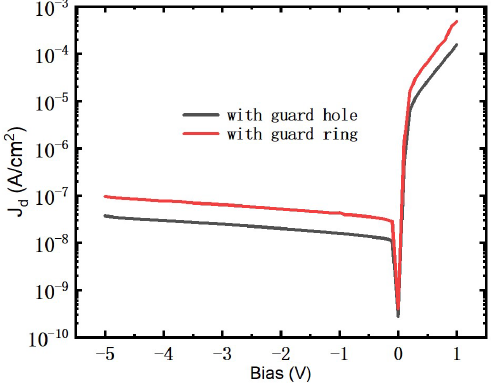
Figure 5. Dark current density of two structures.